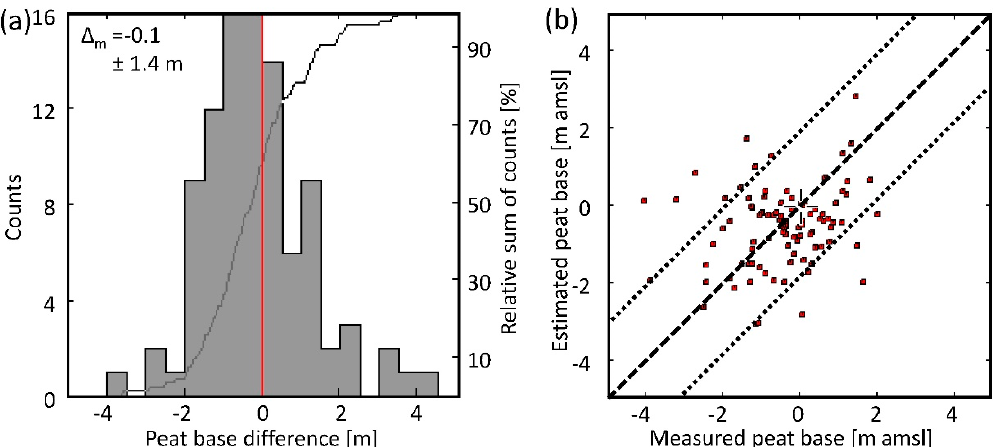
Figure 16. Comparison of airborne and borehole data: ( a ) histogram of differences (vertical red line: ∆ = 0 m) and ( b ) scatter plot (dashed: 1:1 line and dotted: ± 2 m lines) of elevations of peat base derived from HEM.